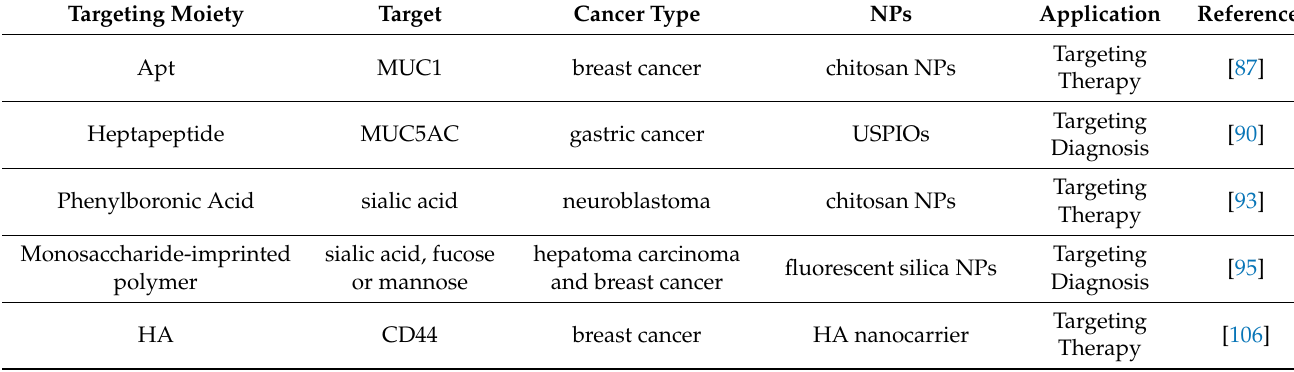
Table 3. Examples of recent innovative anti-glycan approaches to target NPs to cancer